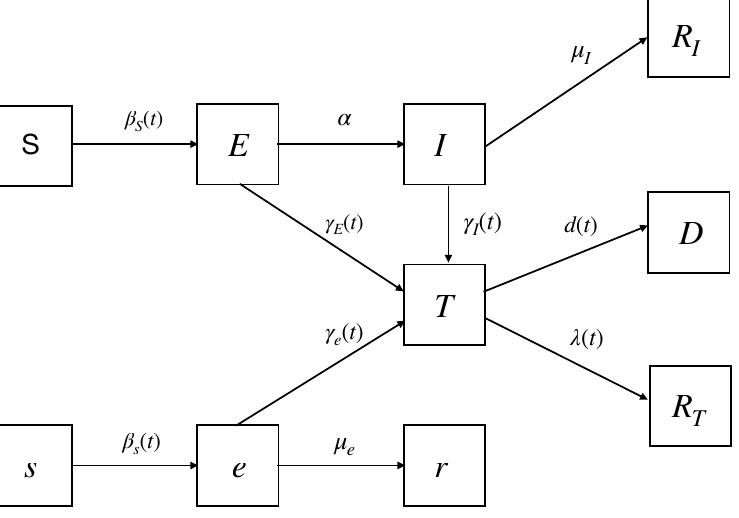
Figure 1. COVID-19 transmission flow